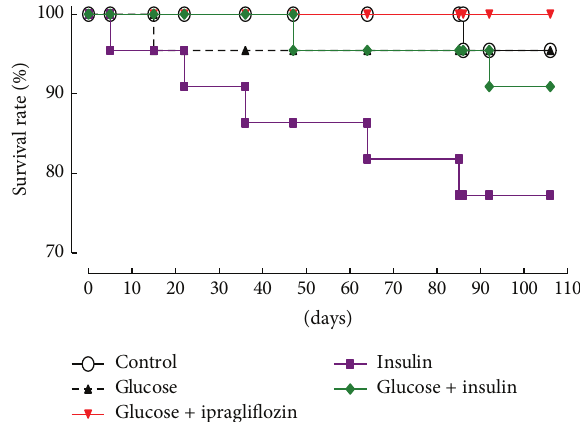
Figure 2: Survival rates of each treatment group. Kaplan-Meier curves indicated significantly reduced survival rates of mice of the insulin group. 𝑃 < 0.05 by the log-rank